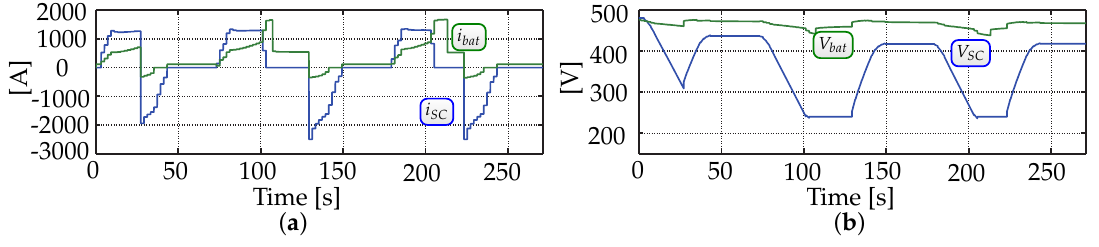
Figure 6. Simulation results for one-step predictive horizon single-objective optimization energy management systems (EMS with three typical stops in the driving cycle of the LR: ( a ) battery current and SC current and ( b ) battery voltage and SC